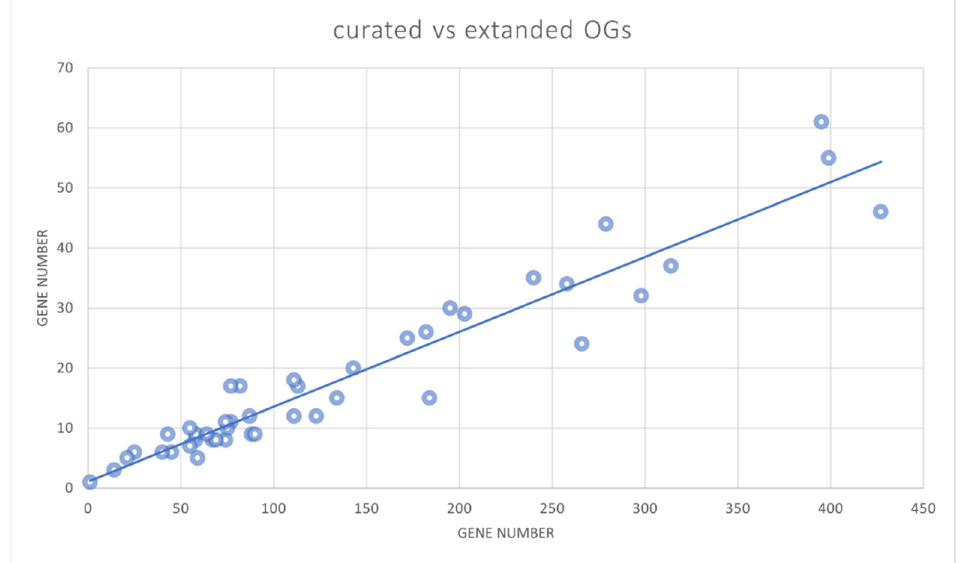
Figure 5. Correlation between the number of GELP members in the curated sequence set (nine species) (Y axis) and the member number in the 46 species (X axis). ( Y axis) and the member number in the 46 species ( X